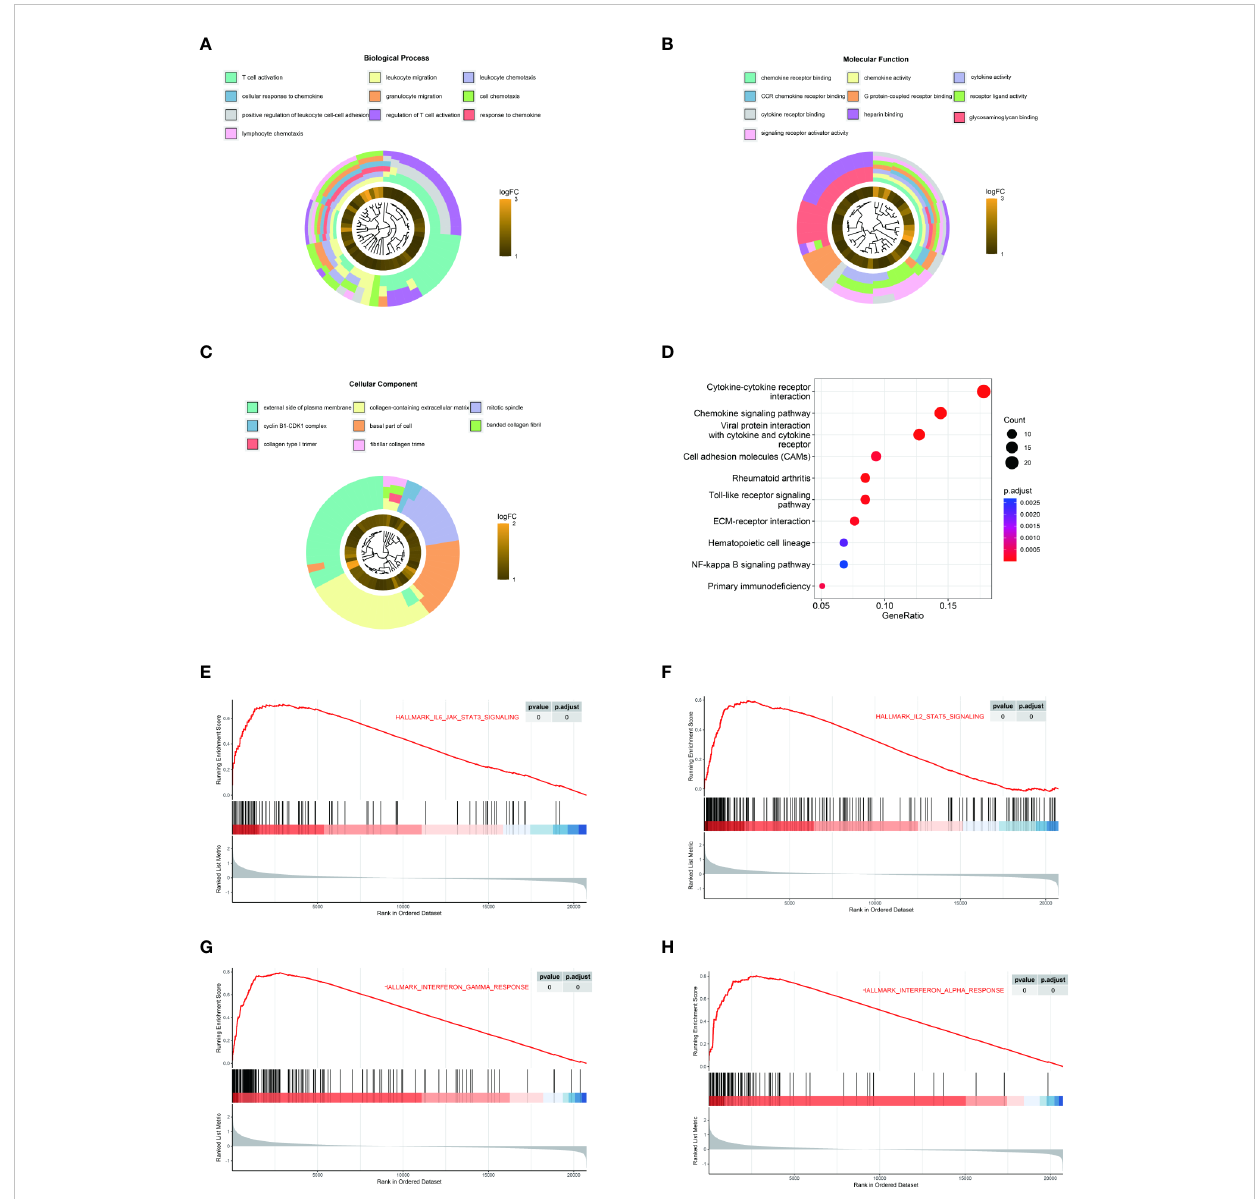
FIGURE 2 LAMP3 upregulation is associated with T cell activation and adaptive immune regulation. (A – D) GO analysis and KEGG pathway enrichment of 216 upregulated DEGs. (E – H) GSEA showed that LAMP3 is positively associated with various bioprocesses of T cells. DEGs, differentially expressed genes; KEGG, Kyoto encyclopedia of genes and genomes; GSEA, Gene Set Enrichment Analysis; LAMP3, lysosome-associated membrane glycoprotein